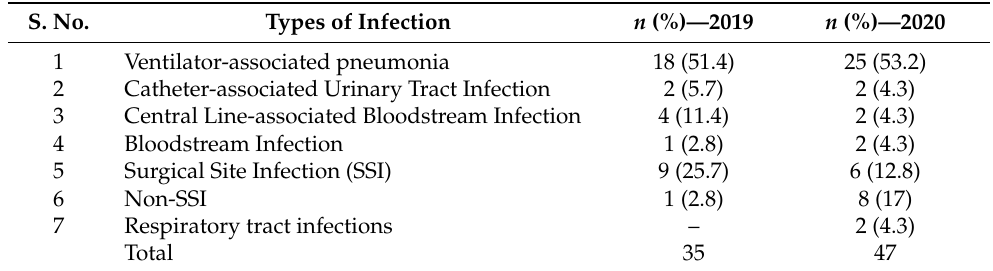
Table 3. Comparison of A. baumannii isolated from different clinical infections from 2019 to 2020. S. No.